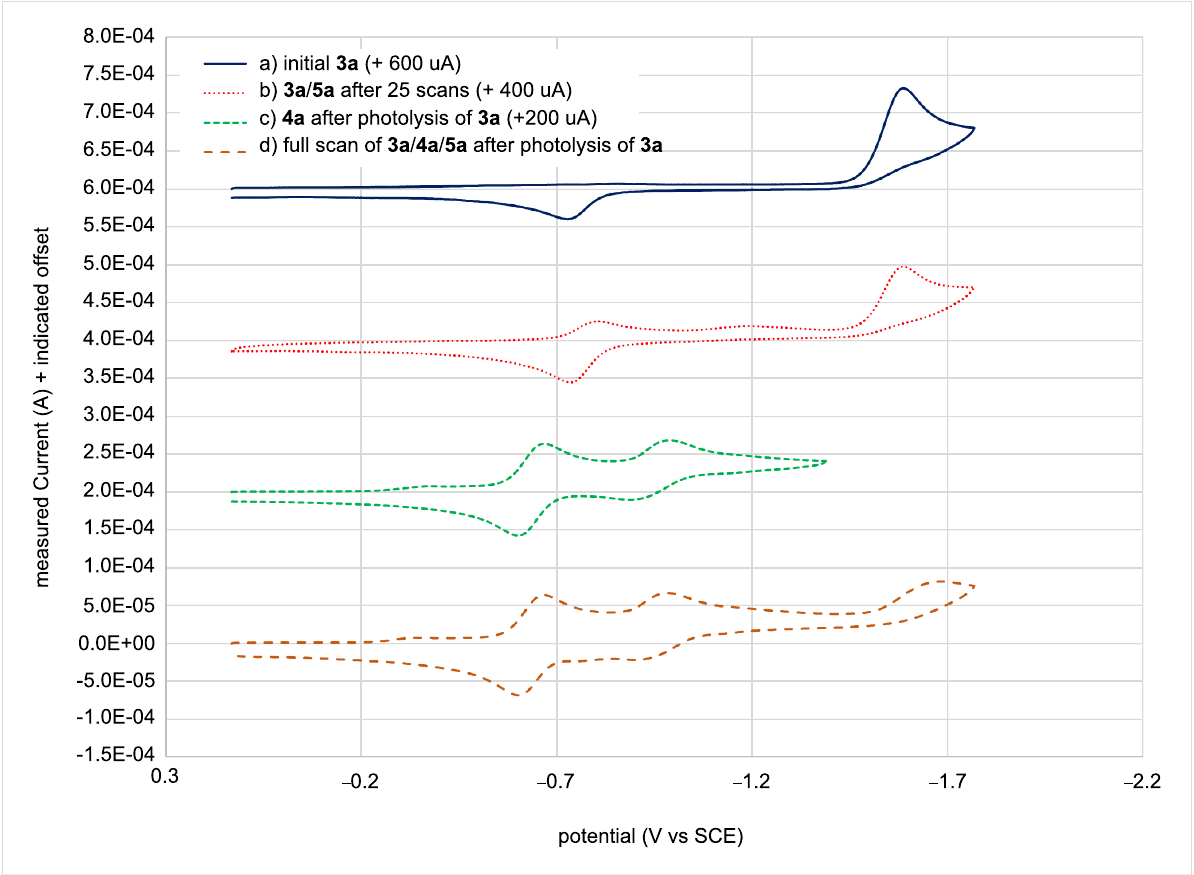
Figure 4: Cyclic voltammograms of a) 3a before irradiation or electrolysis (solid blue), b) 3a + 5a after 25 scans (dotted red) showing the growth of the two eLW 5a reduction peaks, c) 3a after photolyzing but without reducing 3a in the electrolysis (dashed green) which shows the two different revers- ible redox waves observed for pLW 4a , and d) 3a + 4a + 5a scanning the full potential window after the photolysis (dashed